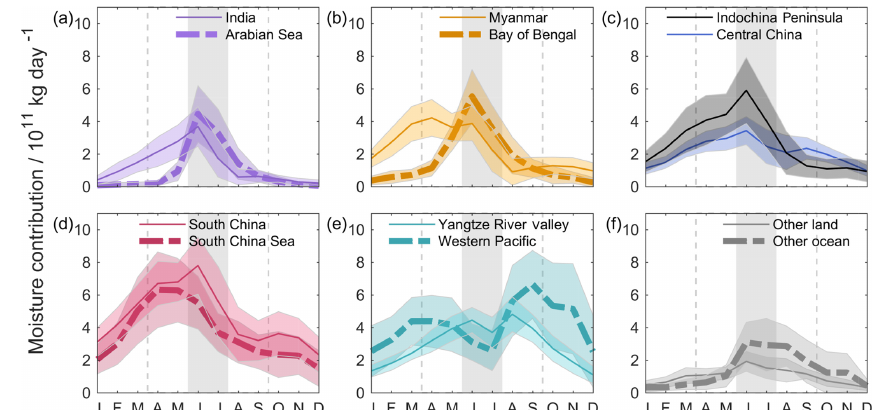
Figure 5. Moisture contribution from different source regions. Division and colors correspond to those in Fig. 4. Thick dashed lines show oceanic regions, while thin continuous lines show continental regions. The wettest half of the year is marked, with peak-precipitation months June and July shaded. Contribution and standard deviation of contribution are shown for the different regions: (a) Arabian Sea and India, (b) Bay of Bengal and Myanmar, (c1) Indochina Peninsula, (c2) Central China, (d) South China Sea and South China, (e) Western Pacific and the target region of the lower Yangtze River valley, and (f) remaining ocean and land regions. The units are 10 11 kgd − 1